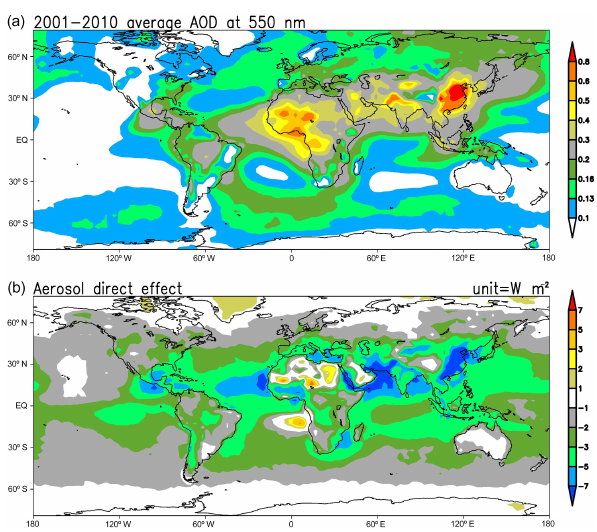
Figure 1. (a) The 2001–2010 mean 550nm AOD obtained by inte- grating MODIS, MISR and AERONET AOD. (b) The 2001–2010 mean direct aerosol radiative effect at TOA, as estimated by a ra- diation model that includes observationally derived surface albedo. The aerosol radiative effect estimate here includes natural